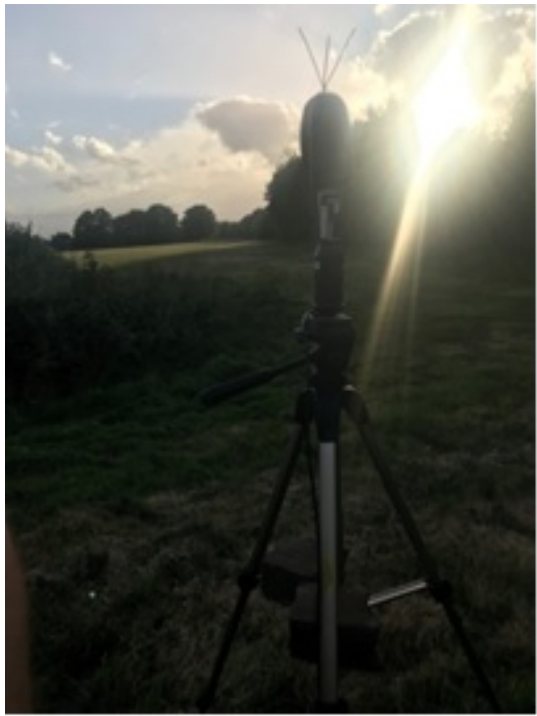
Figure 3: Rurally located monitor station, Case Study A